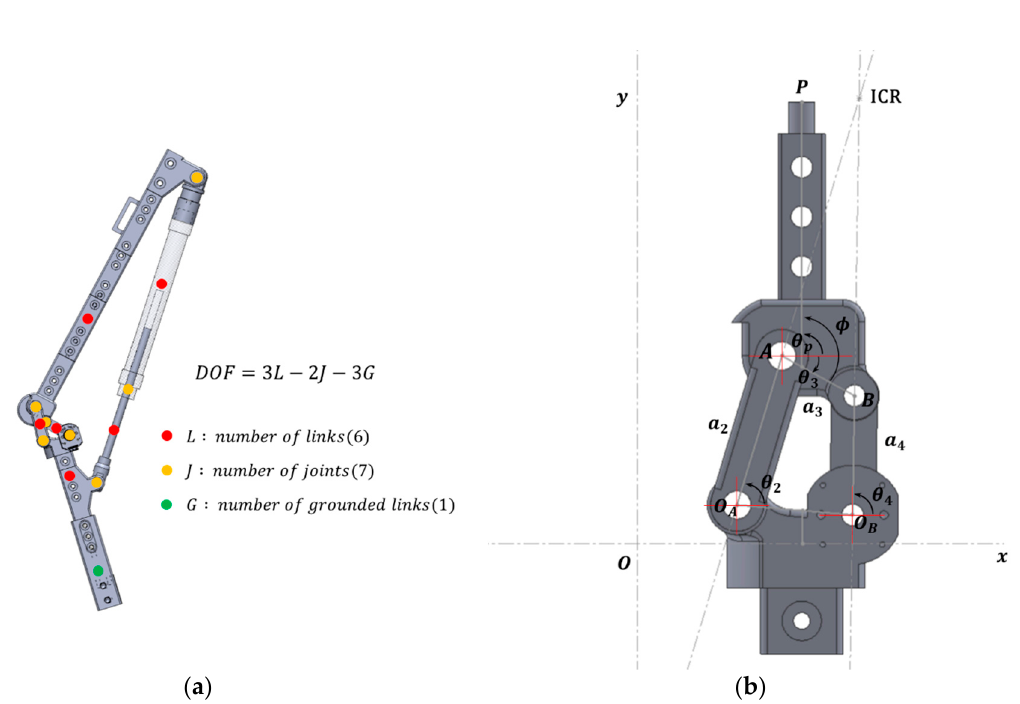
Figure 3. Design of the knee structure and determination of the number of degrees of freedom (DoF): ( a ) calculation point of the degrees of freedom; ( b ) configuration of a polycentric knee with coupler point 𝑃 . ICR is instantaneous center of rotation.